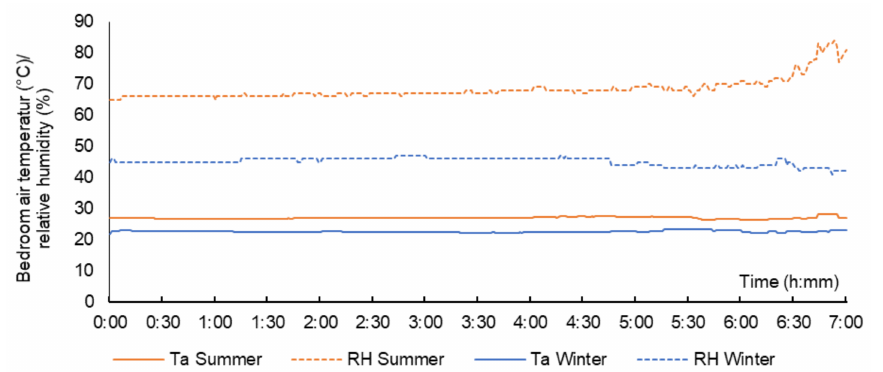
Figure 3. Average bedroom air temperature and relative humidity during sleep by the time; Abbrevi- ation: T a , indoor air temperature, RH, indoor relative